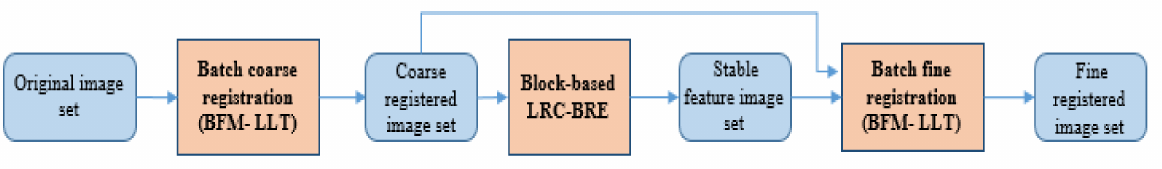
Figure 2. Simple flowchart of the CCFR